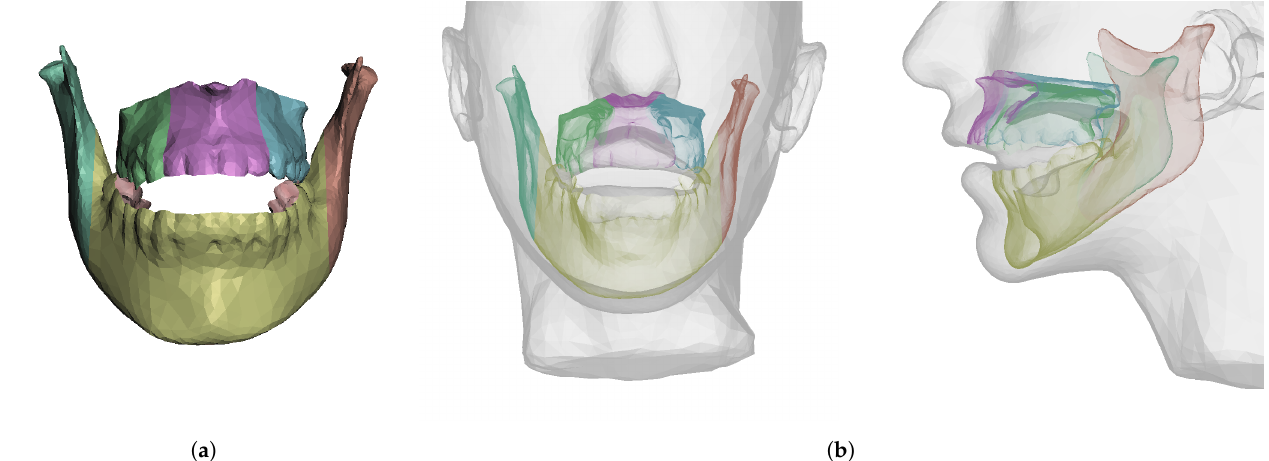
Figure 7. When cutting a bone, the couplings between this bone and soft tissue need to be accordingly split. We pseudo automatically separate the coupled surface of the soft tissue into different face groups in the Boolean subtraction operation. Image ( a ) shows bones cut into 6 fragments and image ( b ) shows the corresponding face groups in the interior of the skin